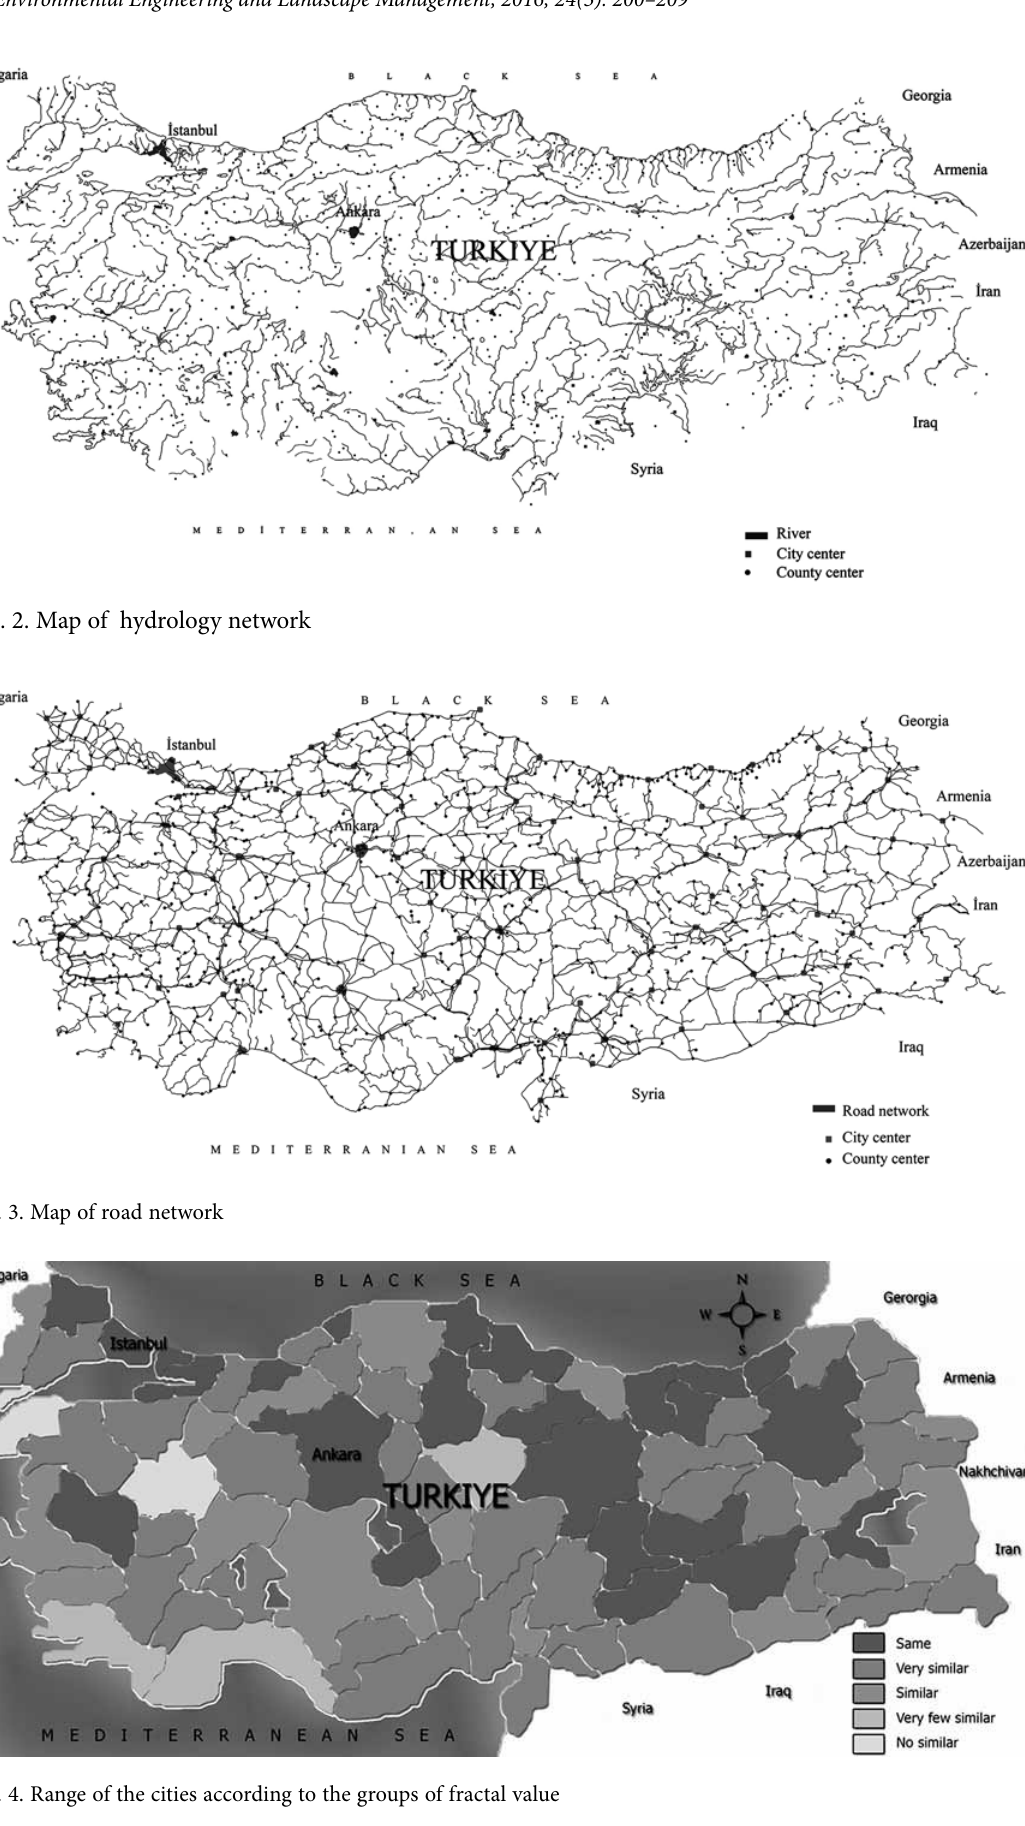
Fig. 4. Range of the cities according to the groups of fractal